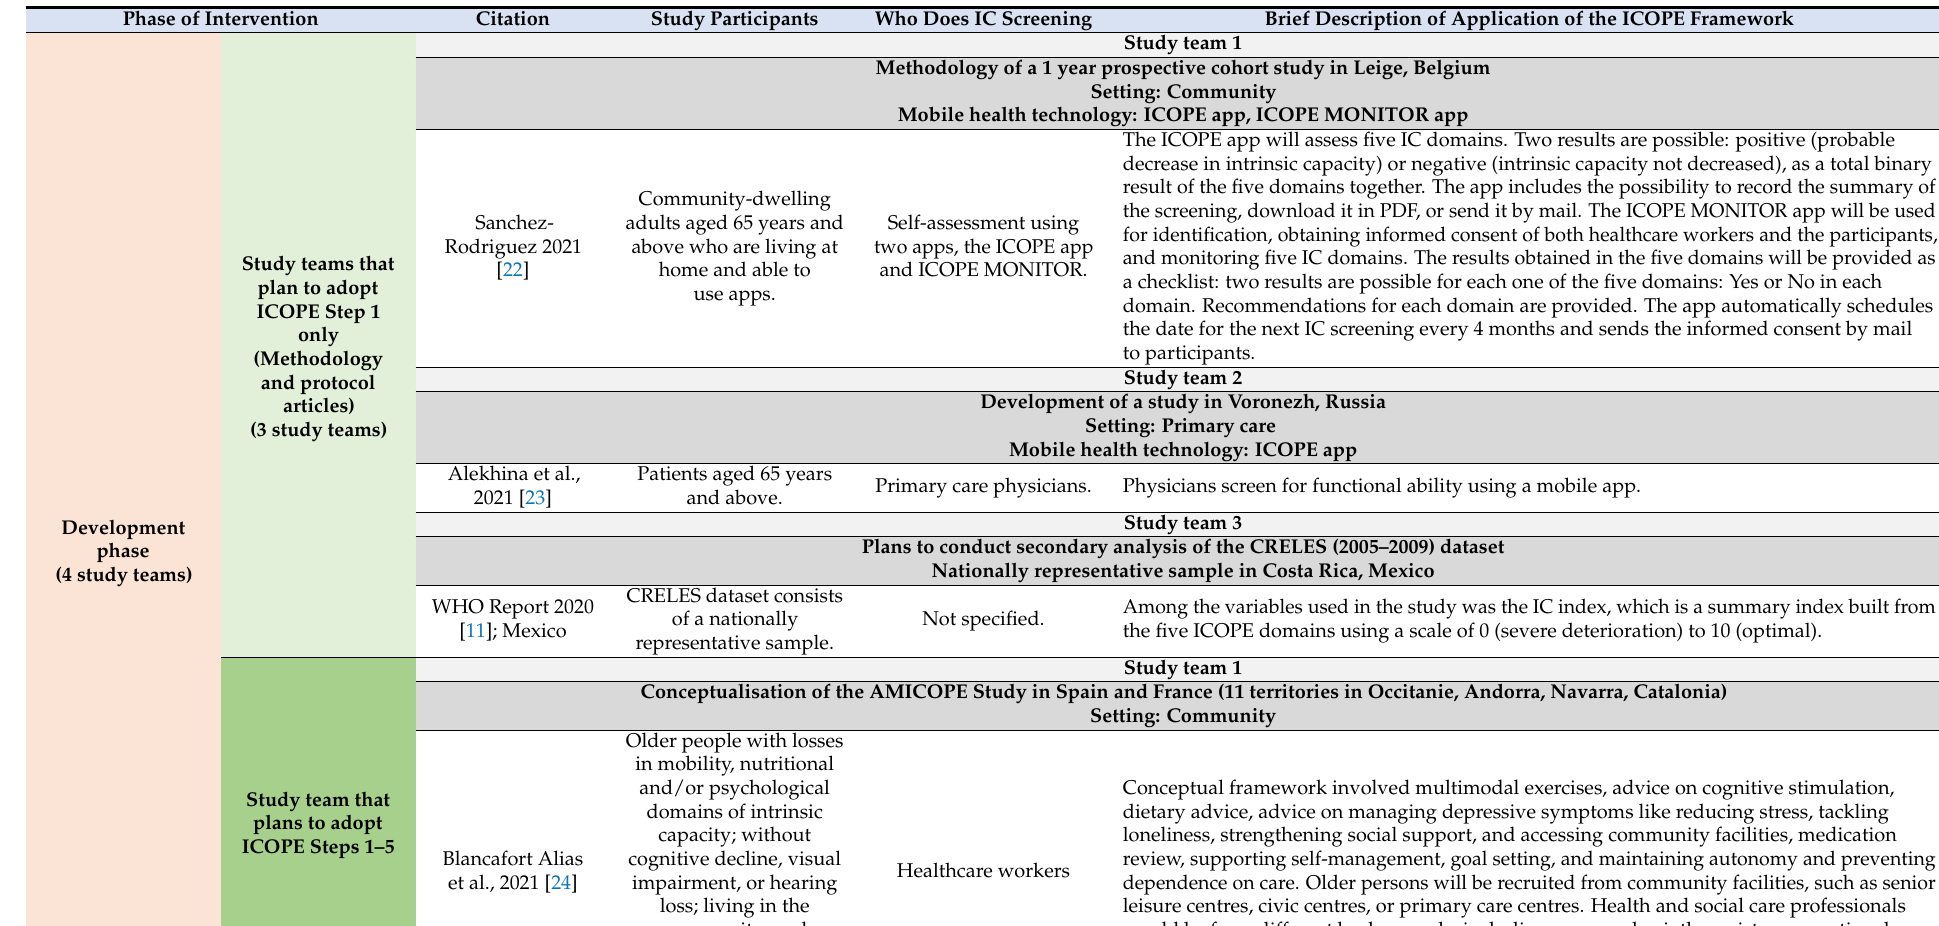
Table 2. Summary of the 18 ICOPE study teams and